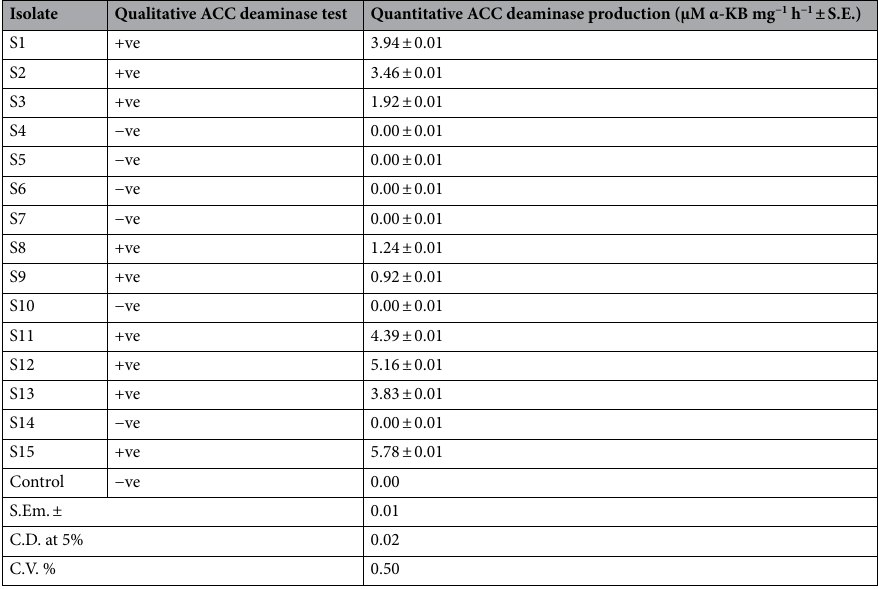
Table 10. Qualitative and quantitative ACC deaminase production profile of isolates. Values are mean ± standard error of three replicates.